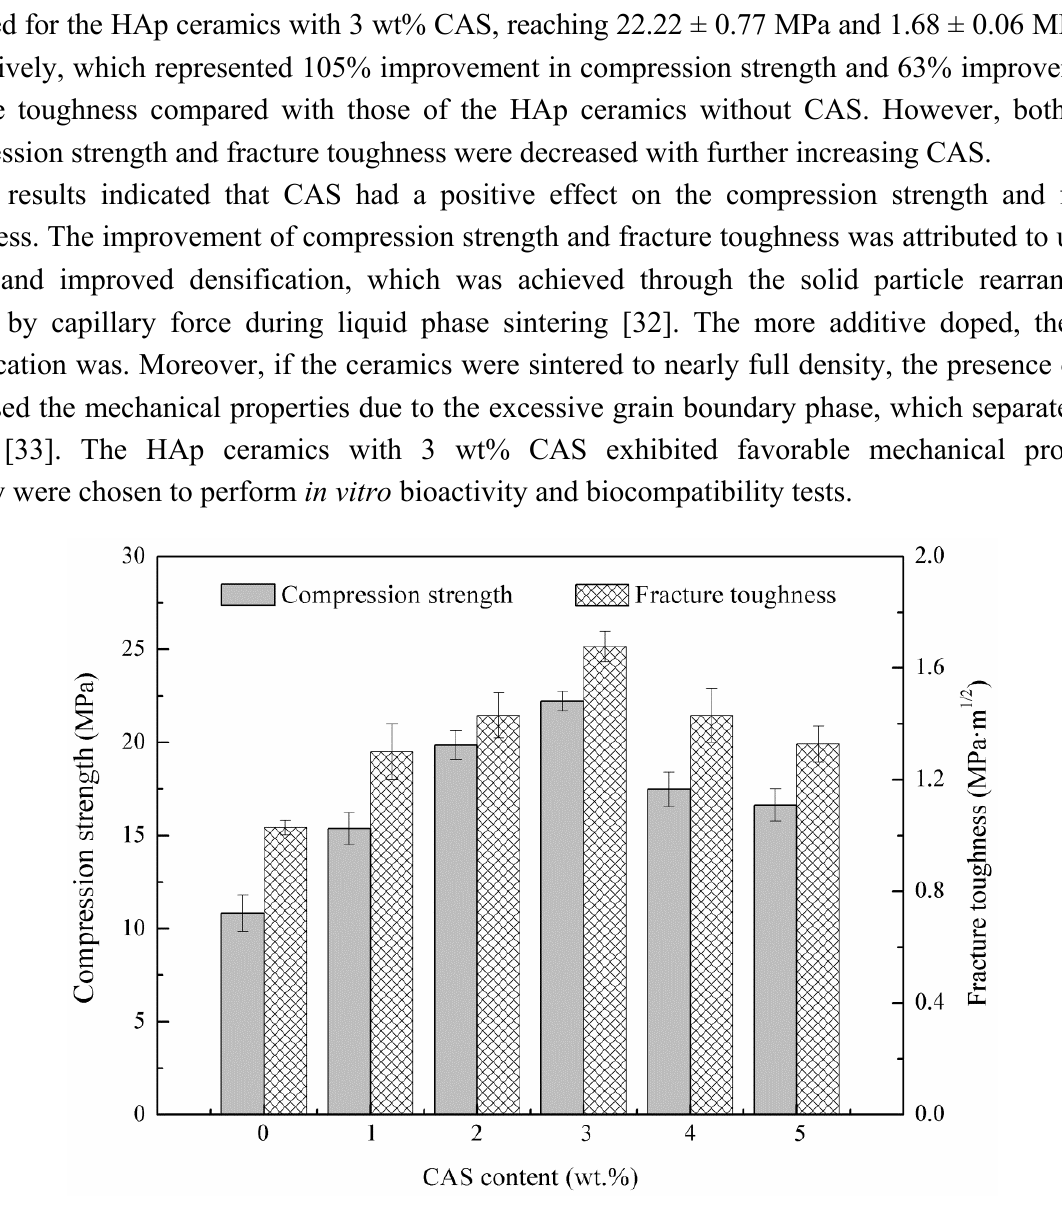
Figure 3. Compression strength and fracture toughness of the HAp ceramics as a function of